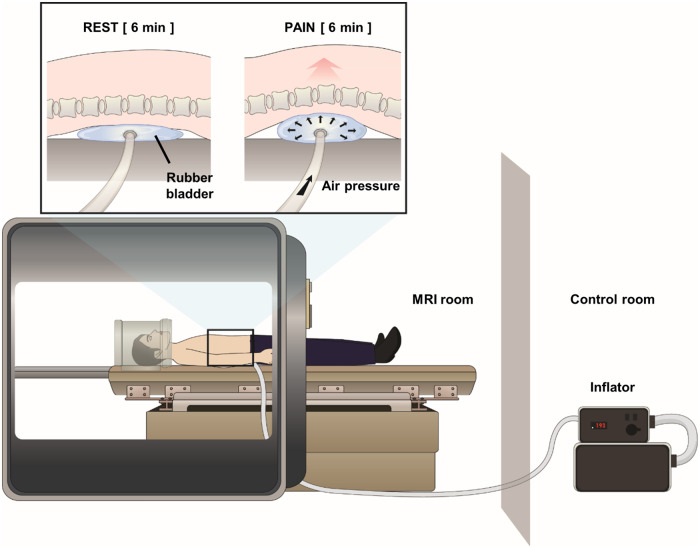
Low back extension pain model and its application in an MR environment.Air pressure was applied to the rubber bladder to allow low back extension in the supine position (in PAIN). Pressure was controlled via manual operation outside the scanner.